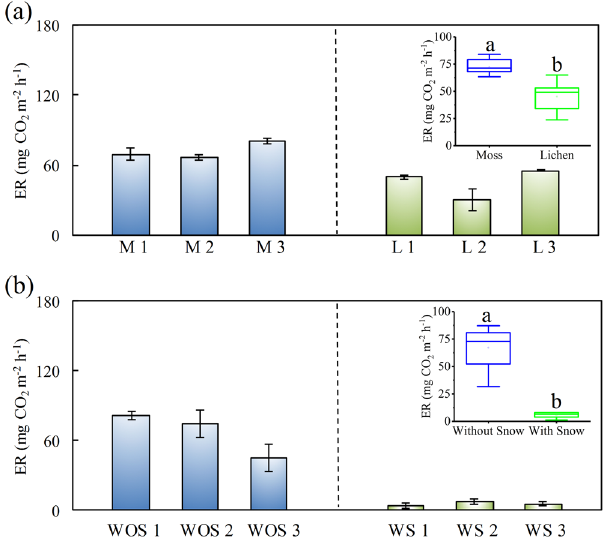
Figure 5. Effects of ( a ) vegetation types and ( b ) snow coverage on ER rates at the upland tundra sites. M 1–3 and L 1–3 indicated the sub-sites with moss coverage and with lichen coverage, respectively. WOS 1–3 and WS 1–3 indicated the sub-sites without snow coverage and with snow coverage, respectively. Boxes enclose the interquartile range, whiskers show the full range. The different lowercase letters indicate statistically significant differences between the means (Fisher’s LSD, P <